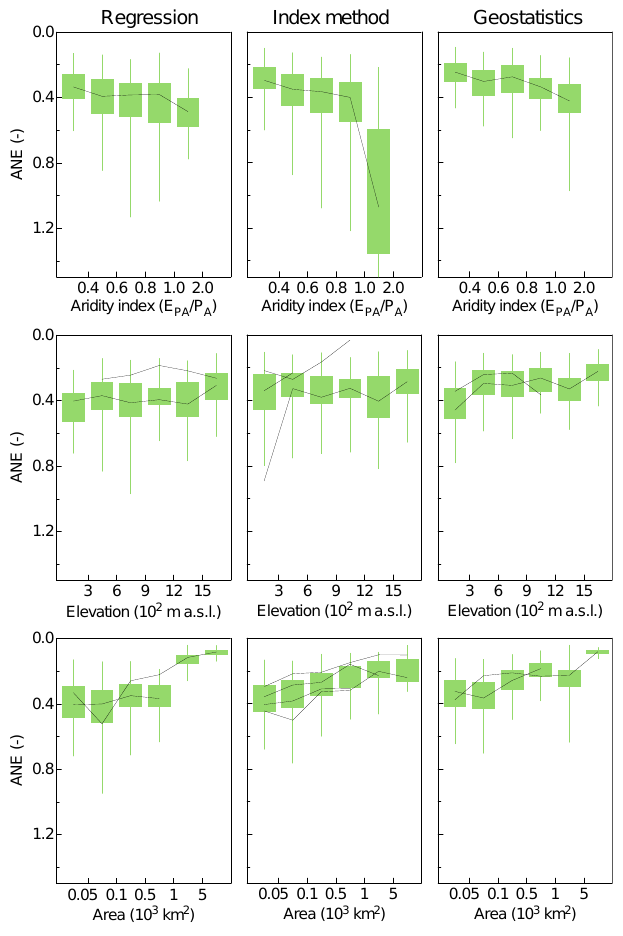
Fig. 7. Absolute normalised error of predicting q 100 floods (m 3 s − 1 km − 2 ) in ungauged basins as a function of aridity ( E PA / P A ) , mean elevation and catchment area for different region- alisation methods (Level 2 assessment). Lines connect median er- rors for the same study. Boxes are 40–60% quantiles, whiskers are 20–80%